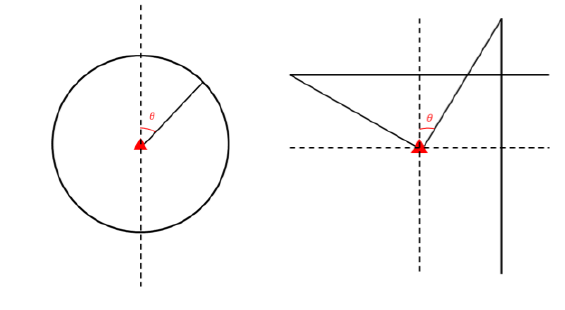
Figure 2 . Geometric configuration.